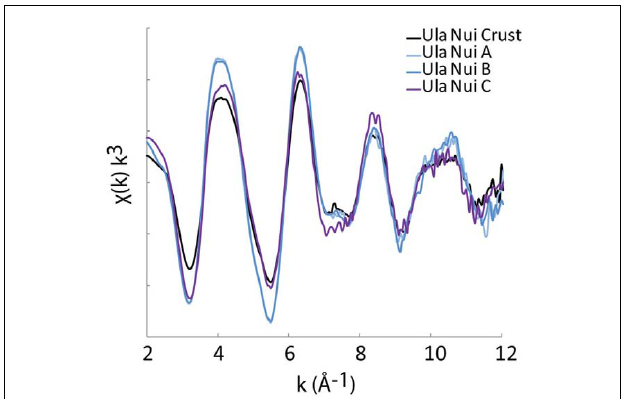
FIGUREA3 | Comparison of PDFs for BT37, SpillwayA, and LohiauA to the Fh reference plotted as G ( r )* r 2 versus r to amplify the features at higher r values. Although subtle for the natural samples the features > ∼ 4Å are reasonable similar to those of synthetic Fh. Note that the PDF for Fh was also multiplied by 0.25 for comparison. Ula Nui-A and -B also showed similar features but due to impurities (e.g., birnessite) were excluded for